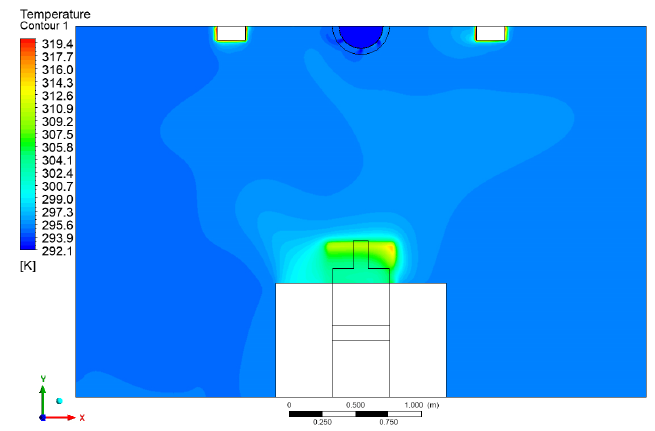
Figure 27. The temperature distribution of the X = 2 m section.